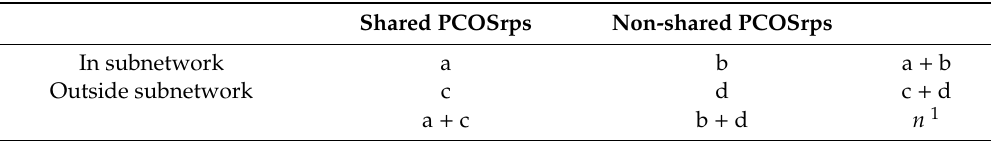
Table 3. 2 × 2 contingency table. The values of a, b, c and d in the table were used in Fisher’s exact